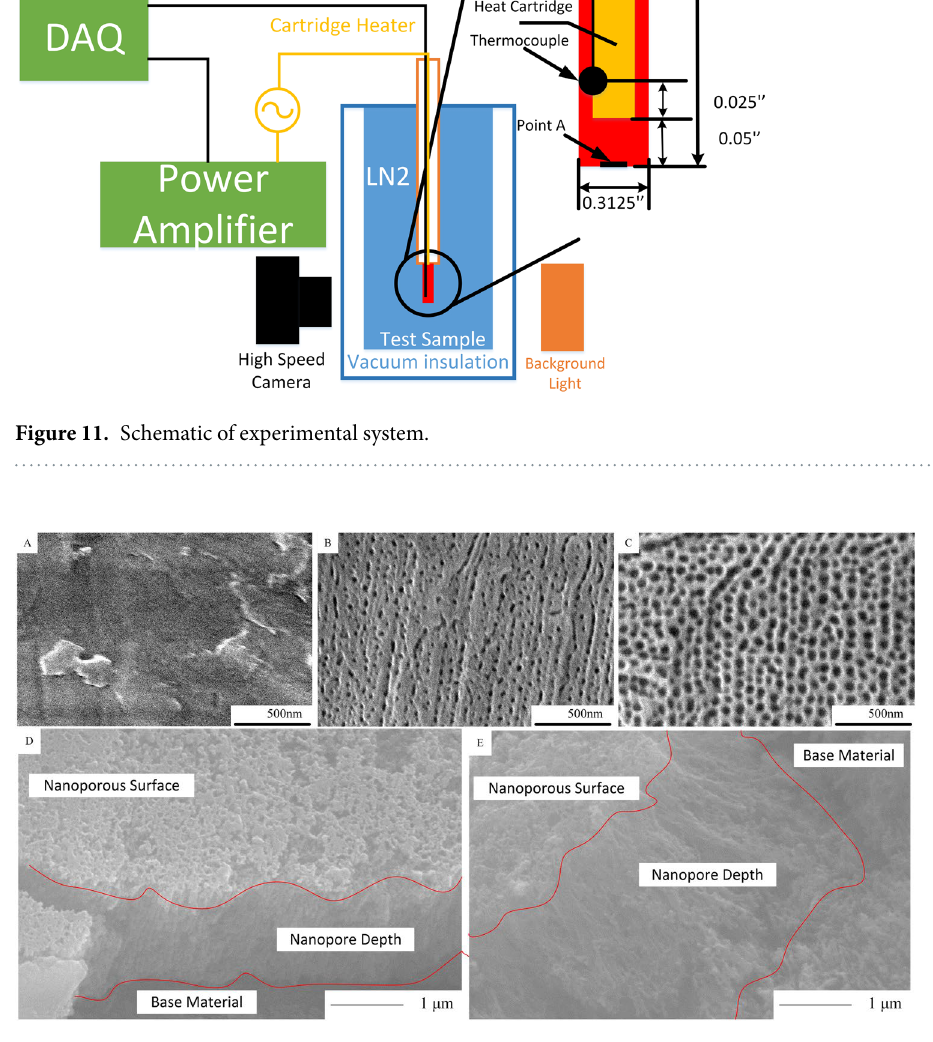
Figure 12. ( A ) Machine polished normal surface, ( B ) PO15 surface and ( C ) PO45 surface, ( D ) Cross-sectional view of PO15 and ( E ) Cross-sectional view for